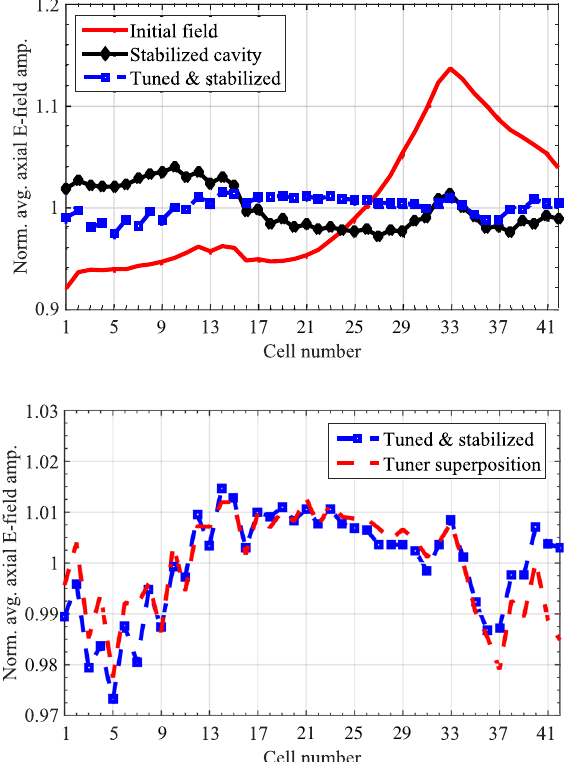
FIG. 14. Top: Field flatness Linac4 DTL Tank 3 before stabilization, after stabilization, and after tuning. Bottom: Zoom showing the final field flatness and the prediction from individual tuner measurements.